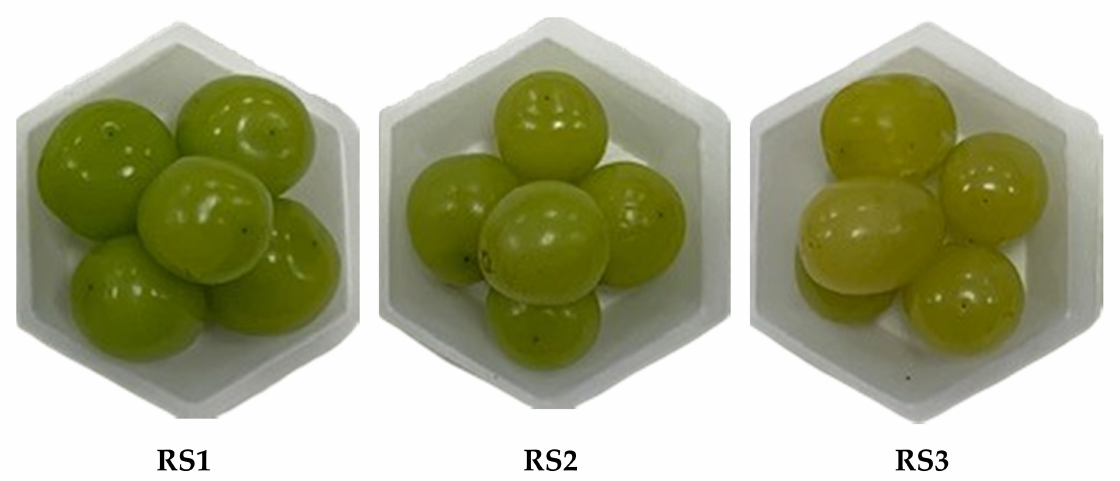
Figure 2. Visual appearances of Shine Muscat berries at di ff erent ripening stages: RS1 , ripening stage 1; RS2 , ripening stage 2; and RS3 , ripening stage 3. The increasing numbers behind the abbreviation RS indicate the degree of